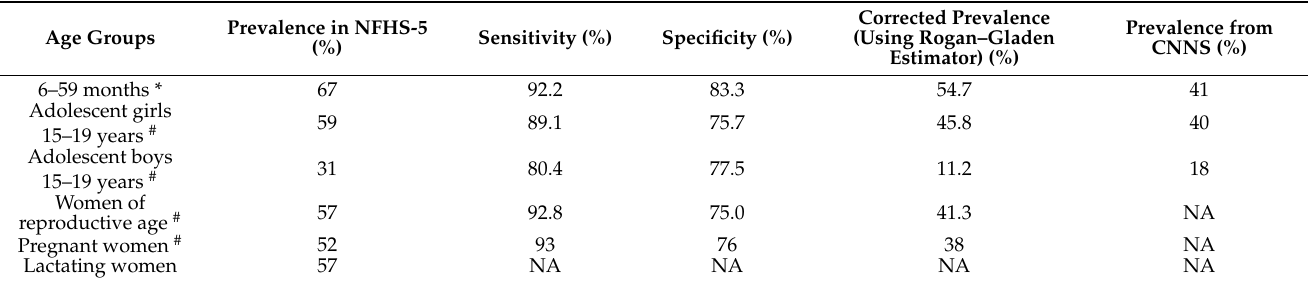
Table 4. Comparison of the burden of anemia in NFHS-5 and CNNS data in India and estimated true prevalence using Rogan–Gladen